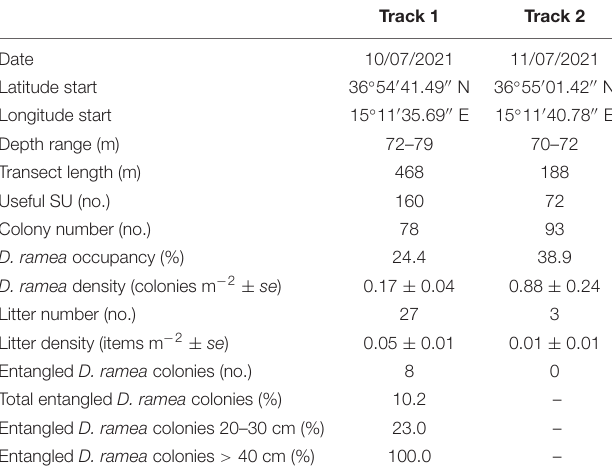
TABLE 1 | Summary of remotely operated vehicle (ROV) tracks performed in the study area with an indication of geographical coordinates, depth, total length, useful sampling units (SUs), Dendrophyllia ramea colonies (no.), occupancy (%), density (colonies m − 2 ), and percentage frequency (%) of entangled colonies by abandoned, lost, or otherwise discarded fishing gear (ALDFG), along with litter number (no.) and density (items m − 2 ).